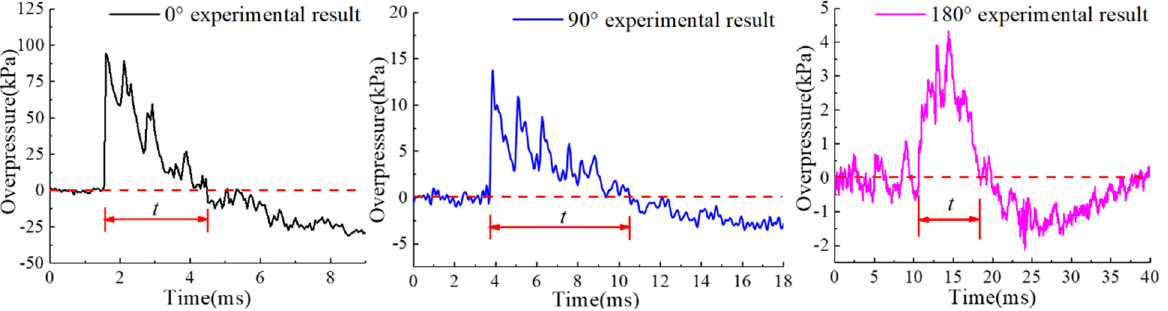
Figure 7. Typical pressure-time histories in different directions. Table 2. Pressure parameters.